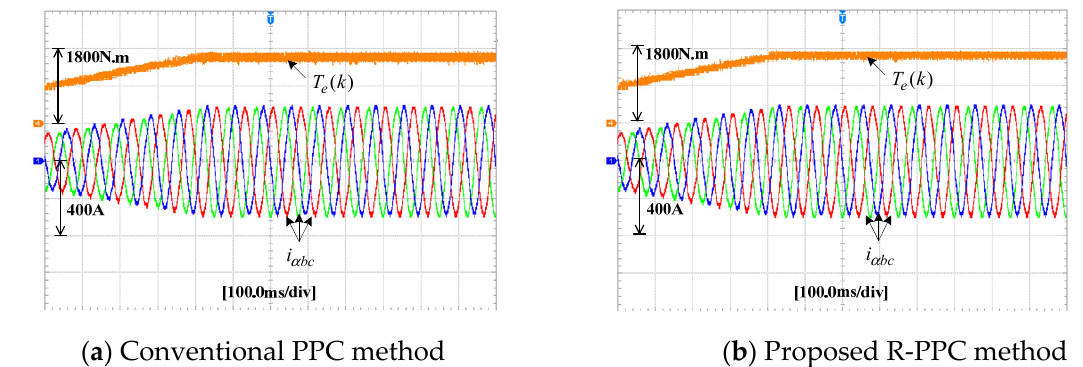
Figure 17. Experimental results of the phase current and torque under the charge state. ( a ) Conventional PPC method; ( b ) Proposed R-PPC method.